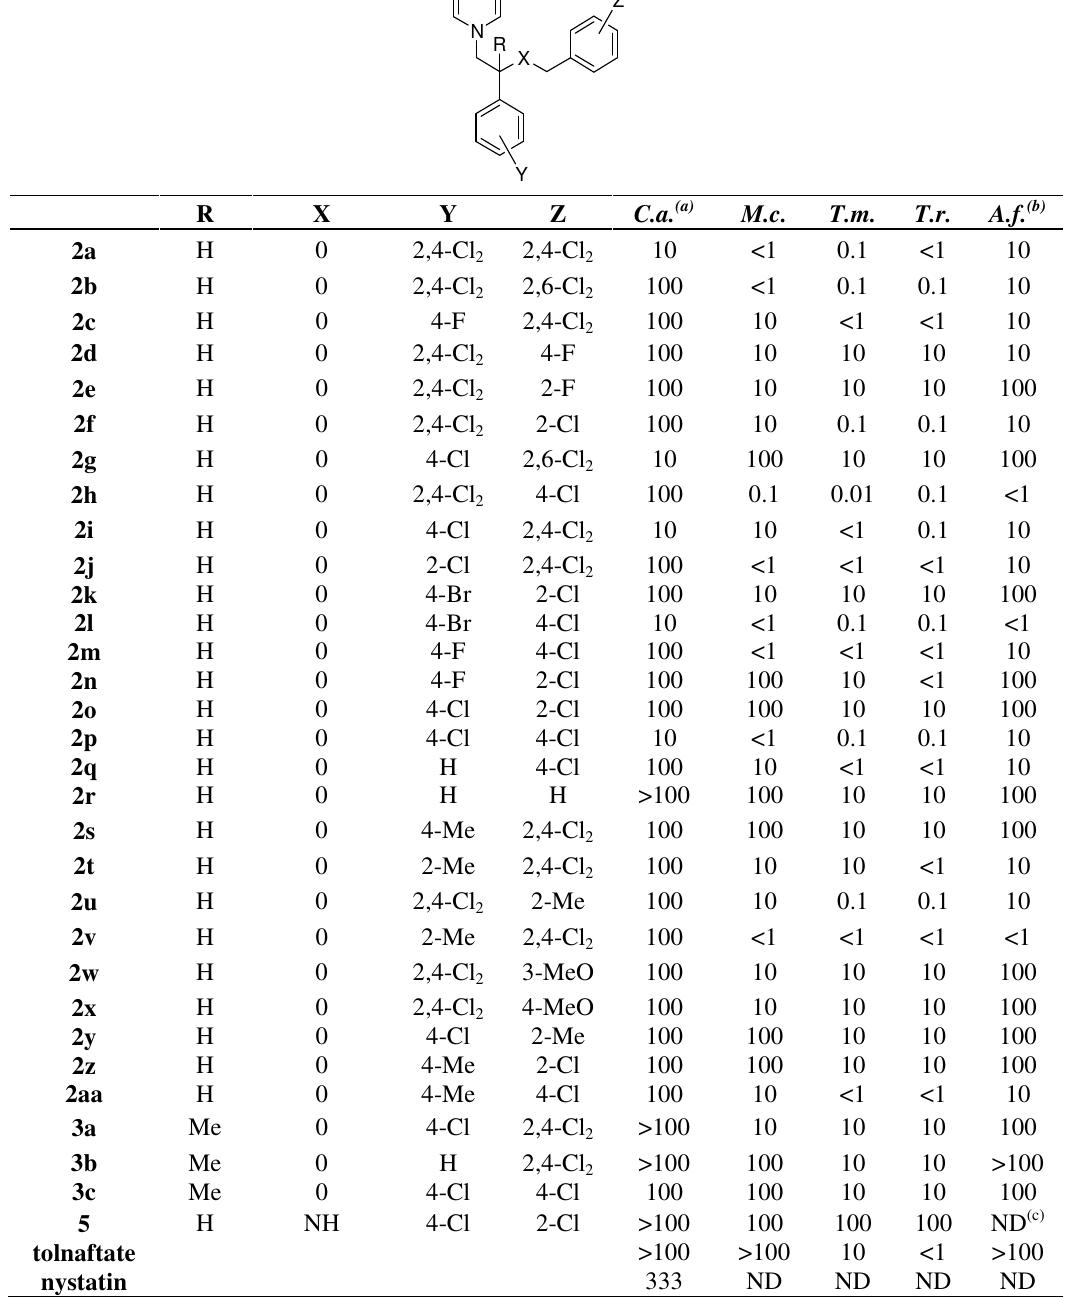
Table 1. In vitro antifungal activity of miconazole and analogues